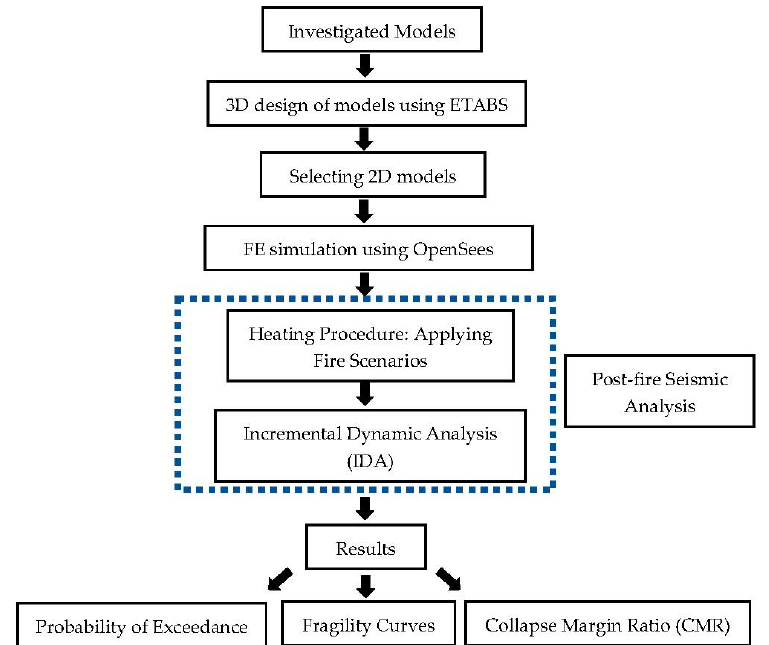
Figure 1. Assessment procedure for post-fire seismic analyses.